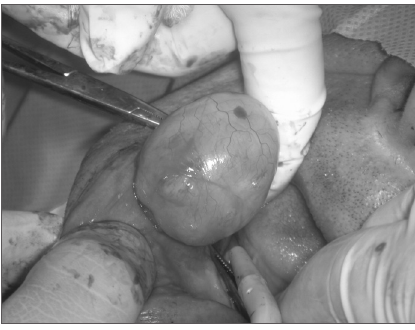
Figure 1. Lipoma - Resection of